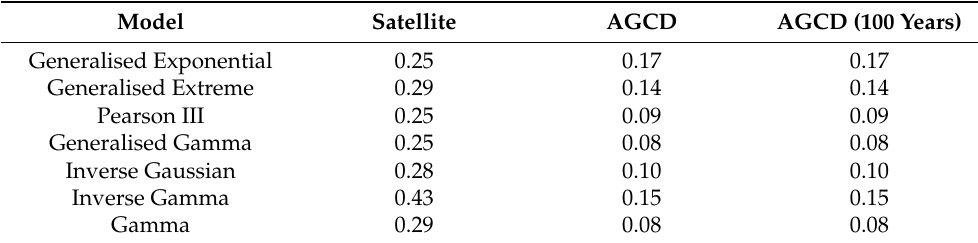
Table A2. Kolmogorov–Smirnov (K-S) goodness-of-fit test for various distributions. Model